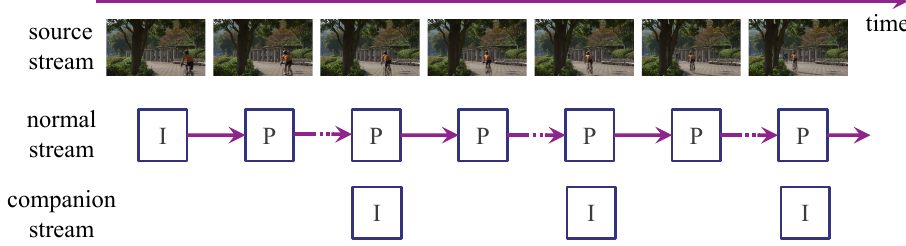
Figure 1. A source video is encoded as a low-latency normal video stream accompanied by a companion stream providing keyframes at specific intervals.